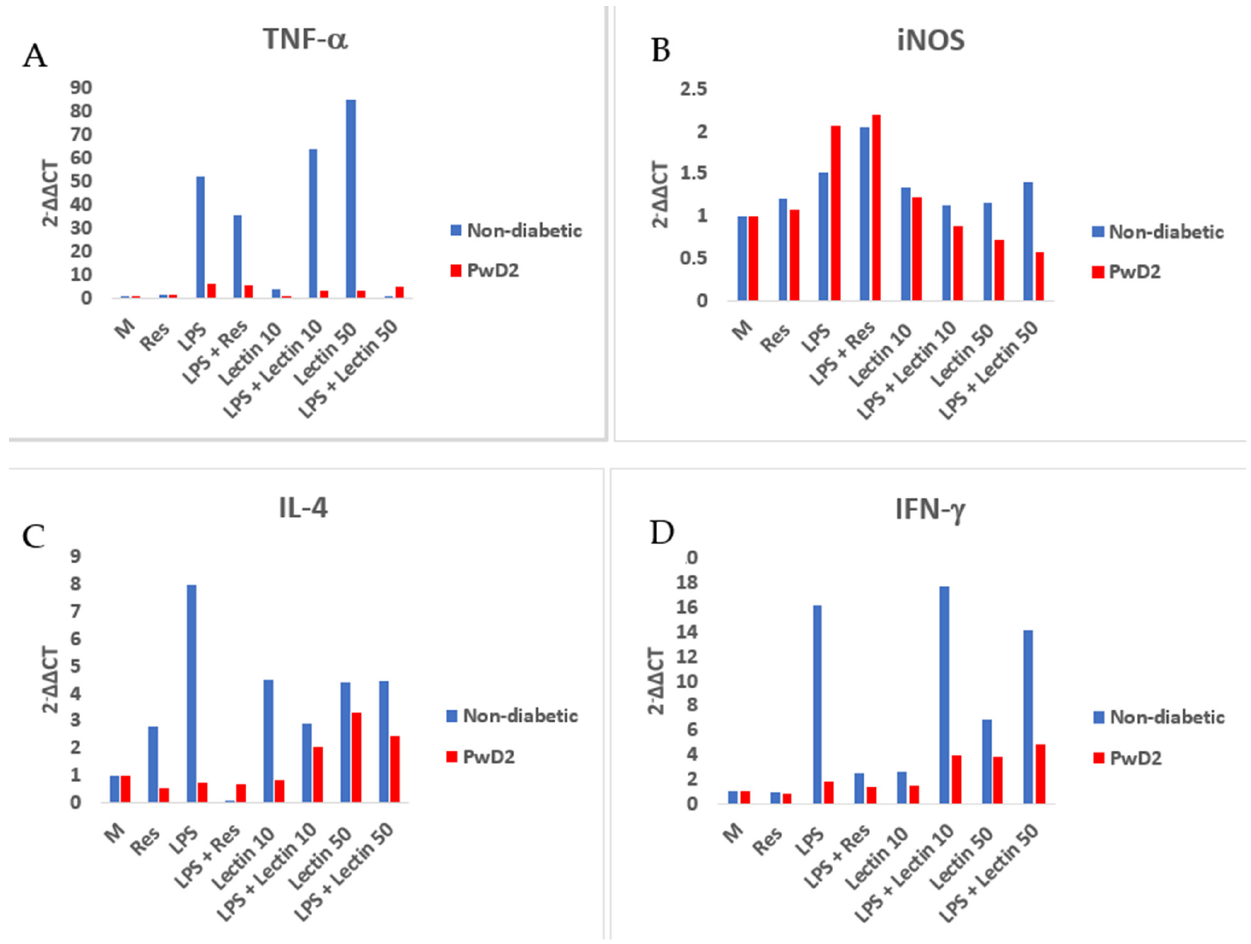
Figure 7. RNA was extracted from cells and gene expression was analyzed using qRT-PCR for validation of NGS data (Expt. 5). ( A , B ) TNF- α and iNOS genes modulated by medium control, LEC10 and LEC50, ( C , D ) IL-4 and IFN- γ genes modulated by different treatments in PBMCs of non-diabetics and PwD2.